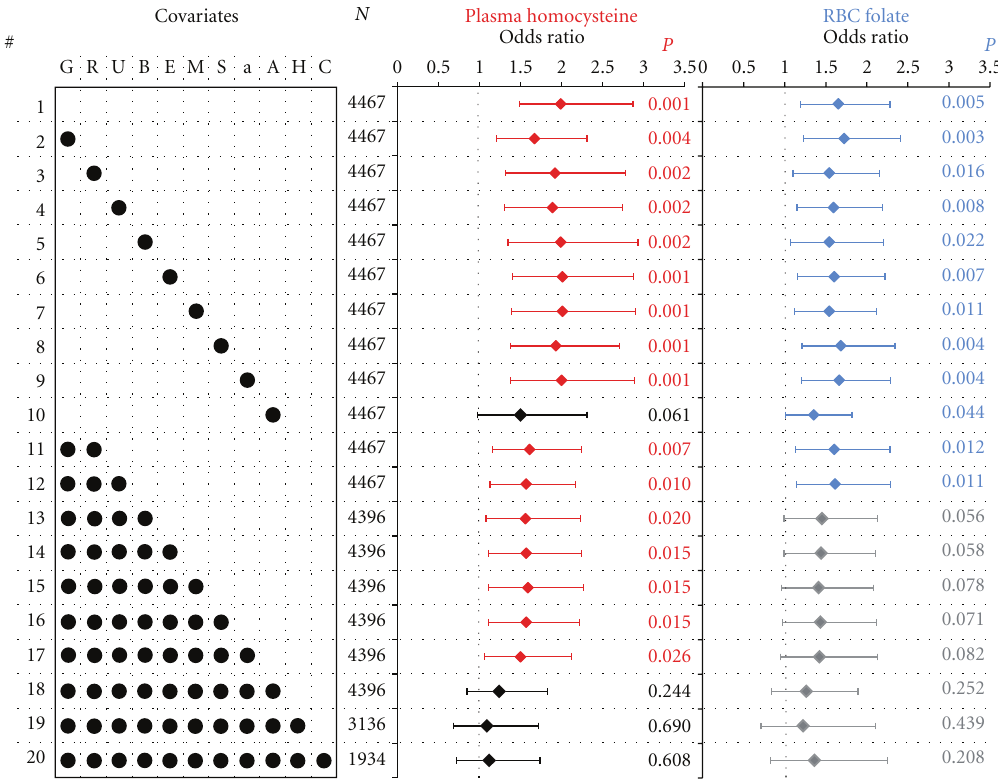
Figure 3: Multivariate association of high plasma homocysteine and RBC folate levels with the risk of self-reported sleep apnea. Results are shown as point (diamonds) and 95% confidence intervals (error bars) for odds ratios estimated through a series of nested logistic regression commands. Twenty logistic regression models (indicated by # on the left) were run with varying combinations of covariates. The covariates included were G: male gender; R: non-Hispanic white race; U: birth in the United States; B: body mass index > 28 Kg/m 2 ; E: high education; M: married; S: ever smoker; a: ever alcohol use; A: age > 46 years; H: hypertension; C: cardiovascular disease. Model 1 contained only high plasma homocysteine and high RBC folate as the independent variables. The results from models 19 and 20 cannot be directly compared with the remaining 18 models since the information for hypertension and cardiovascular disease was not available for a large number of subjects (shown under column titled N ). Statistically significant associations (when the error bars did not straddle unity indicated by dashed vertical lines) are shown in red color for high plasma homocysteine and in blue color for high RBC folate. Statistically nonsignificant associations are shown in black color for plasma homocysteine and gray color for RBC folate. Statistical significance is shown on individual plots as color-coded P